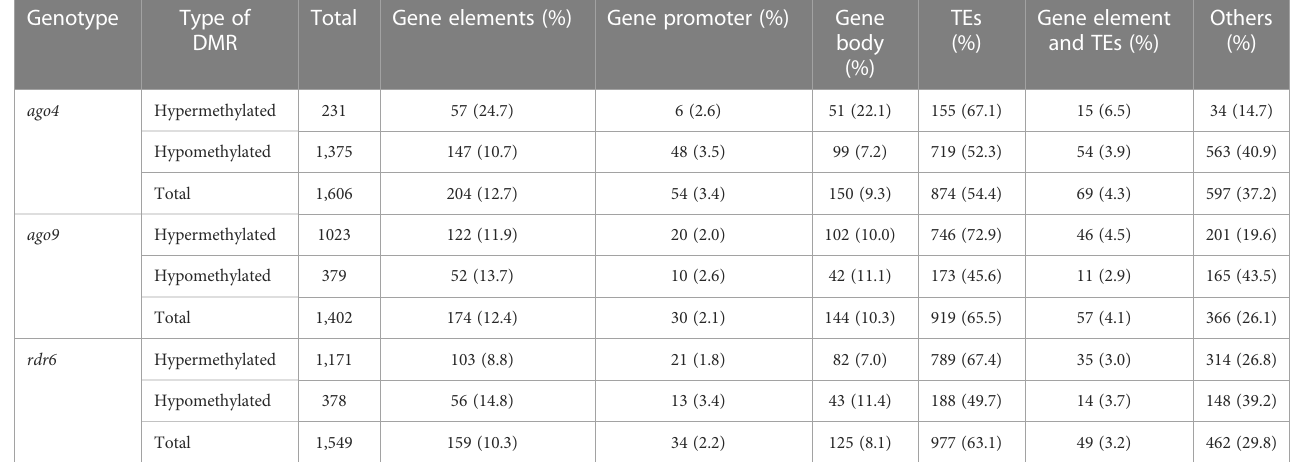
TABLE 2 DMRs mapping to speci fi c genomic regions in the CHH context. Genotype